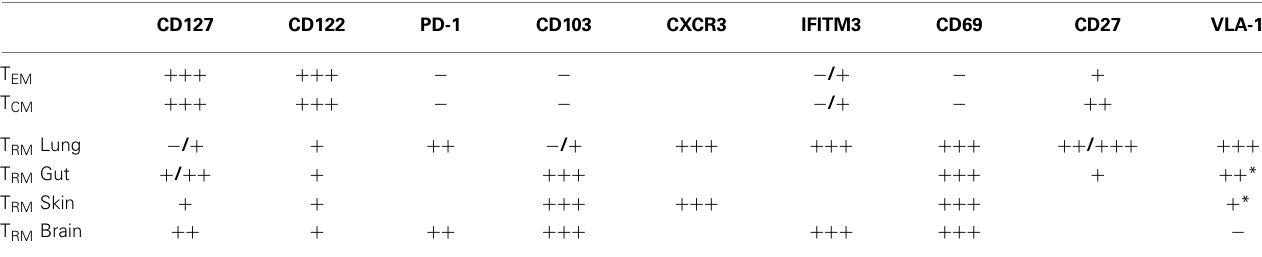
Table 1 | Factors associated with the positioning and survival of defined pools of memory CD8 + T cells in specific anatomical sites